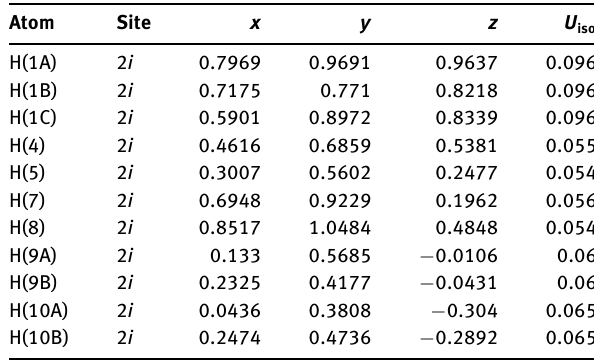
Table 2: Fractional atomic coordinates and isotropic or equivalent isotropic displacement parameters (Å 2 ).